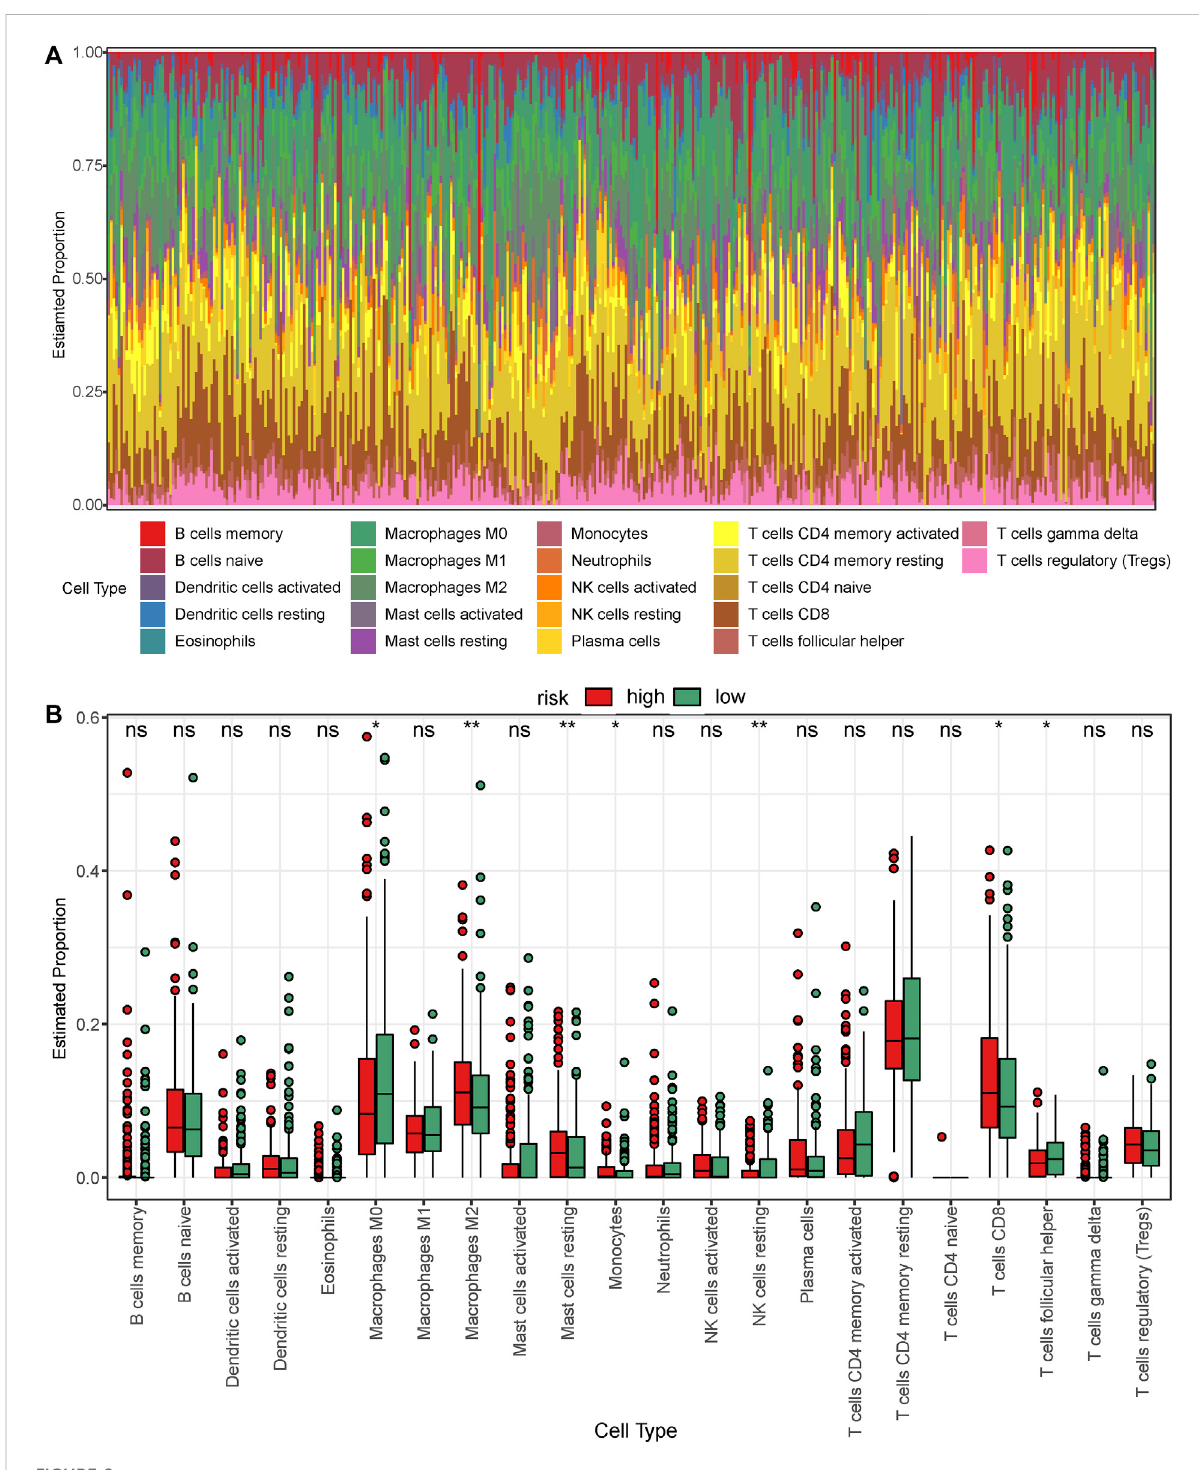
FIGURE 8 Analysis of immune cell in fi ltration in the low- and high-risk patients with gastric cancer in TCGA dataset. (A) Bar graph showing the proportion of each of the 22 immune cell types in the samples. (B) Boxplot comparing the proportion of each of the immune cell types between the low- and high-risk groups. The green and red blocks represent the high- and low-risk groups,